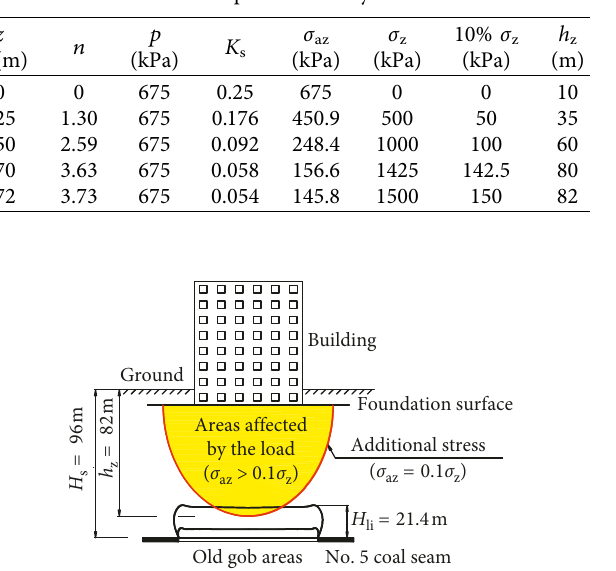
Figure 7: Relationship between the areas affected by the load and the fractured